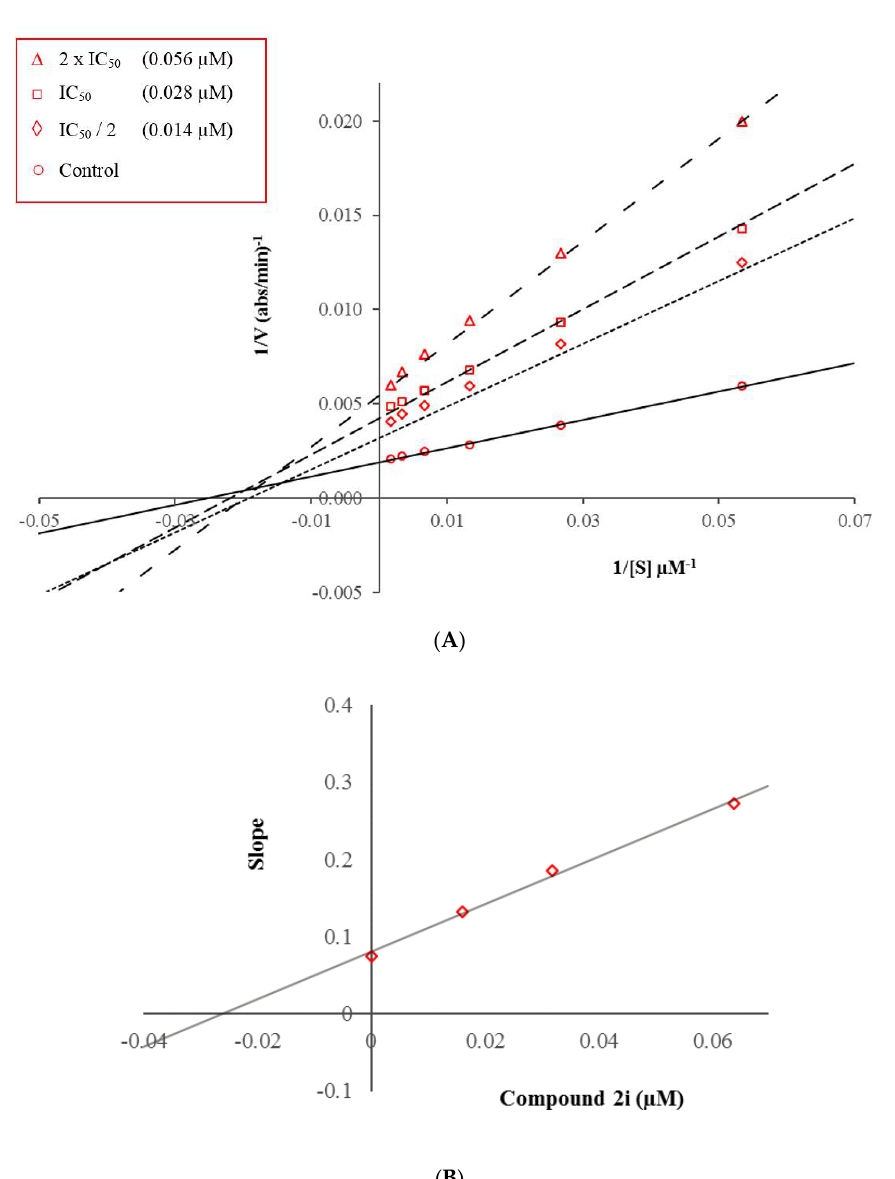
Figure 2. ( A ) Lineweaver–Burk plots for the inhibition of AChE by compound 2i . [S], substrate concentration (µM); V, reaction velocity (1/V (abs/min) −1 ). Inhibitor concentrations are shown at the left. ( B ) Secondary plot for the calculation of the steady-state inhibition constant (K i ) of compound 2i . K i was calculated as 0.025 µM.